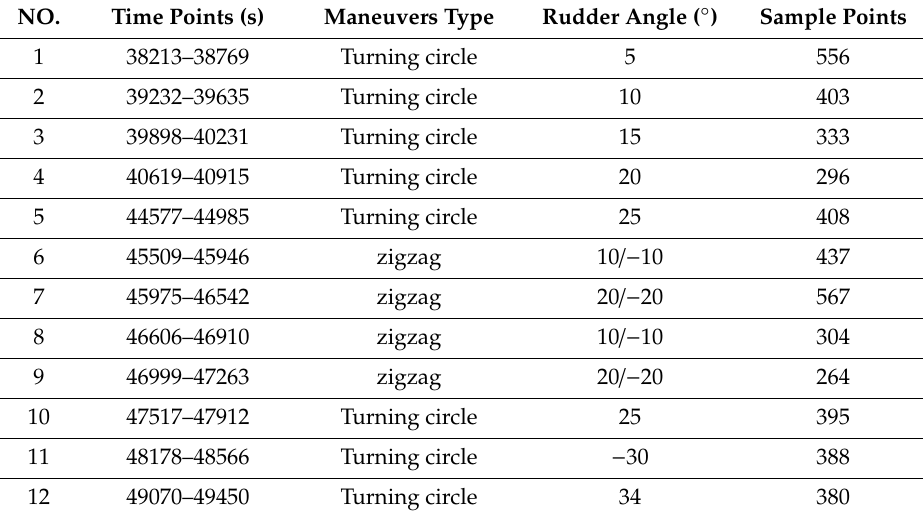
Table 2. Maneuver type and rudder angle details for all of the trials.